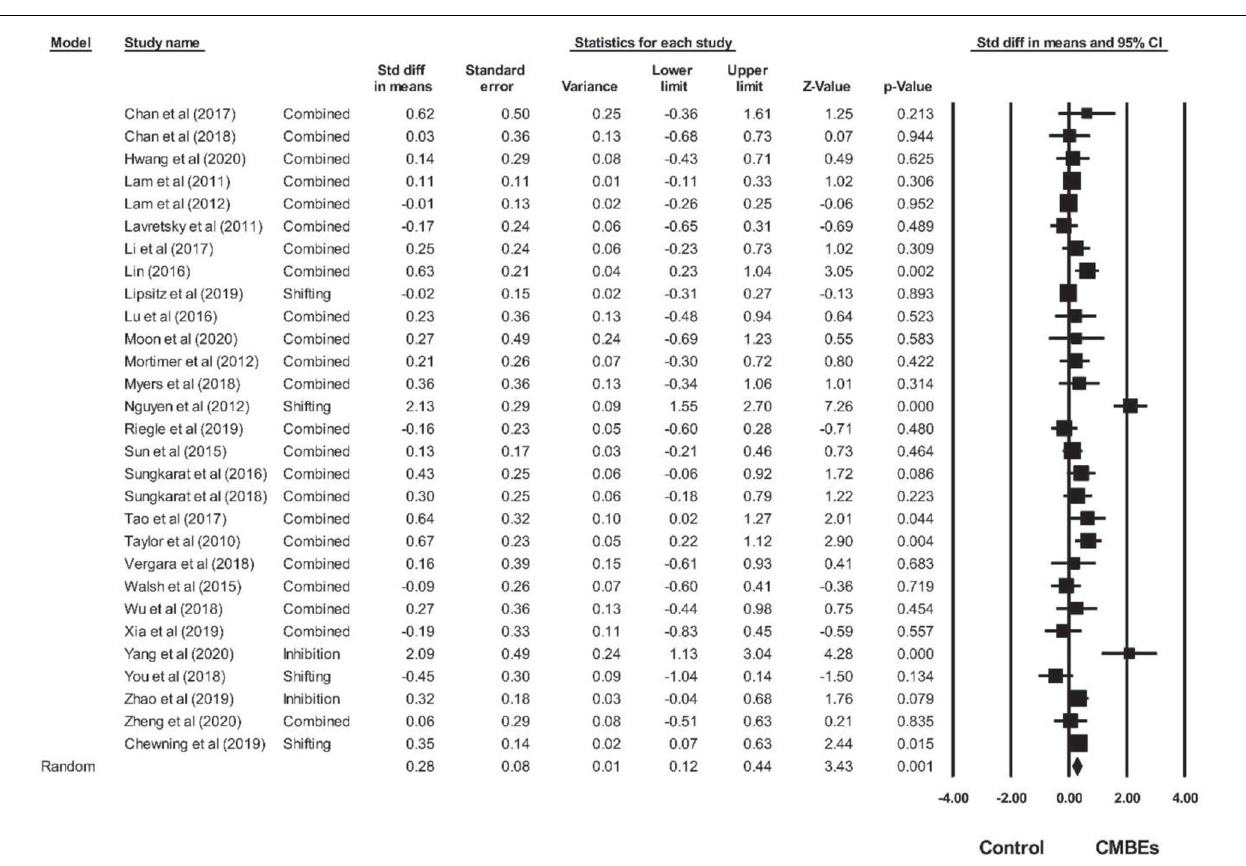
pooled ES for CMBEs was significant and small ES (SMD = 0.28, 95% CI 0.12 to 0.44, p = 0.001), with medium heterogeneity ( I 2 = 68.96%, p < 0.001) compared to the control groups ( Figure 2 ). Regarding publication bias, visual inspection of the funnel plot showed that it was symmetrical, and the results ( t = 1.50, p = 0.14) revealing the absence of funnel plot asymmetry ( Figure 3